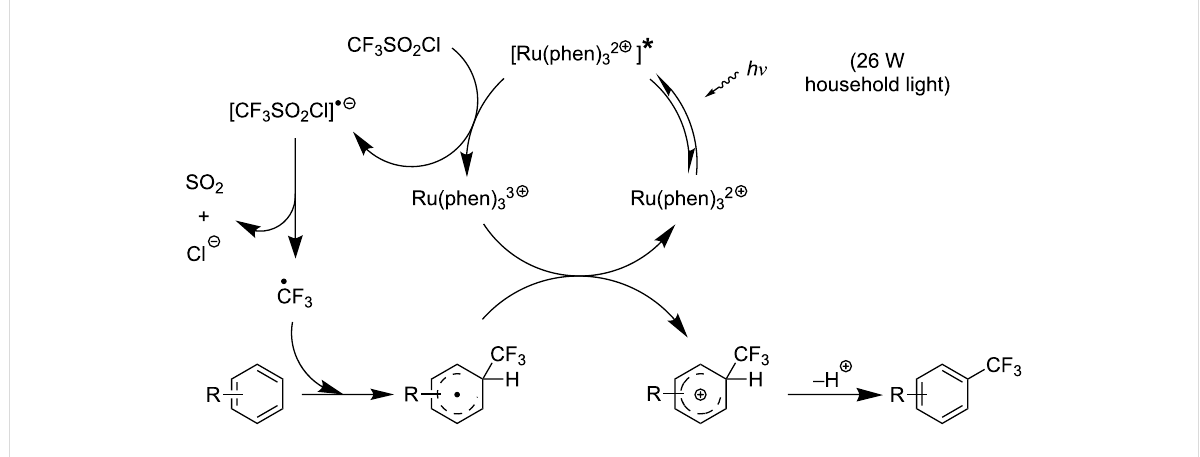
Figure 15: Proposed mechanism for the Ru-catalyzed photoredox trifluoromethylation of (hetero)arenes with trifluoromethanesulfonyl chloride [105].